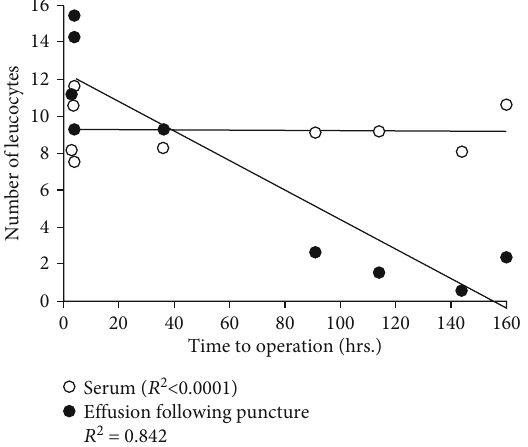
Figure 3: Number of leucocytes in serum and synovial fl uid from ankle fracture paitents ( N =8). The serum leucocyte level remained constant over the fi rst 7 days after ankle fracture ( p =0.50), while the leucocyte level in synovial fl uid (e ff usion) decreased after ankle fracture ( p